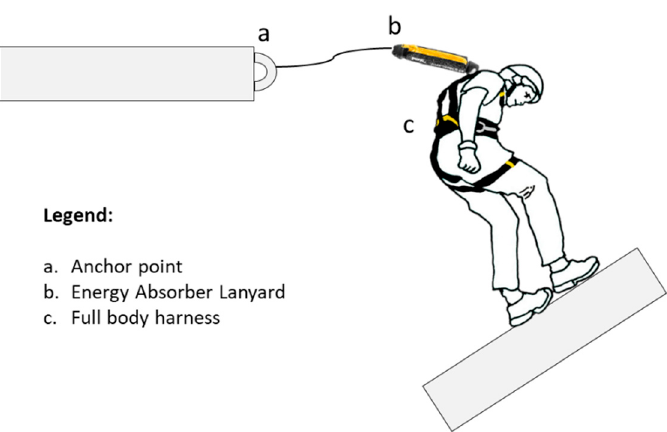
Figure 1. Typ ical fall arrest systems (FAS). Figure 1. Typical fall arrest systems